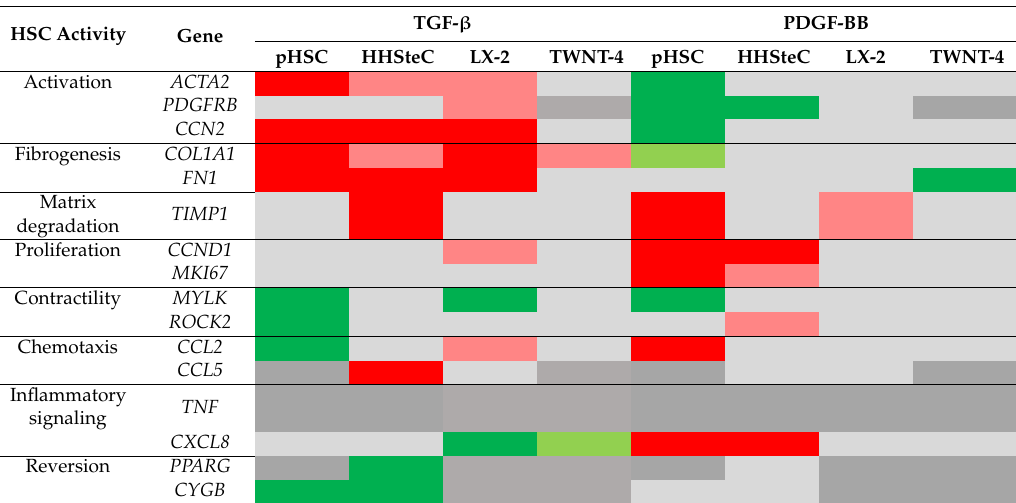
Table 2. Heatmap visualizing the fold inductions of all cells studied and stimulated with TGF β and PDGF-BB relative to the untreated control. Rows represent genes related to the versatile HSC activities in fibrogenesis and fibrolysis. Columns represent the tested cell types. Red color indicates increased gene expression (dark red p < 0.05; light red 0.05 ≤ p < 0.10) and green indicates reduced expression (dark green p < 0.05; light green 0.05 ≤ p < 0.10) as compared to control. No significant e ff ect or no gene expression are depicted in light or dark grey, respectively. Of note, TIMP1 has an inhibitory function on this